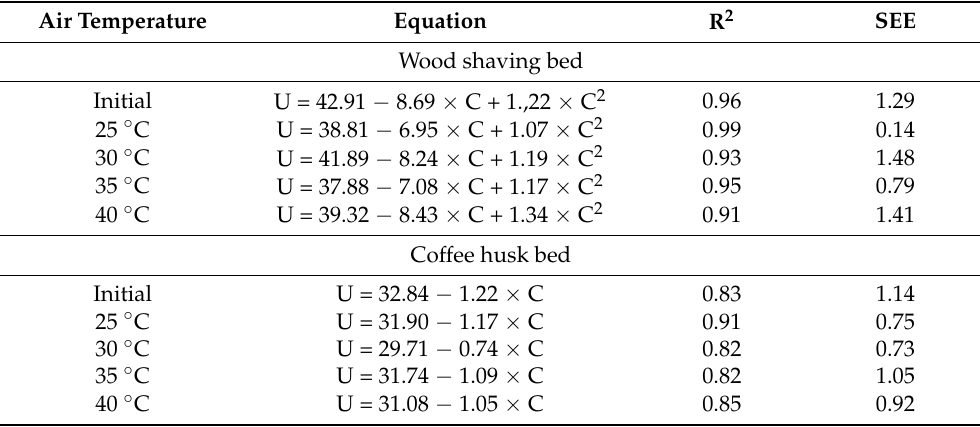
Table 1. Adjusted equations of the moisture behavior of the wood shaving bed and coffee husk bed in relation to the cycle of use, in the different air temperatures.